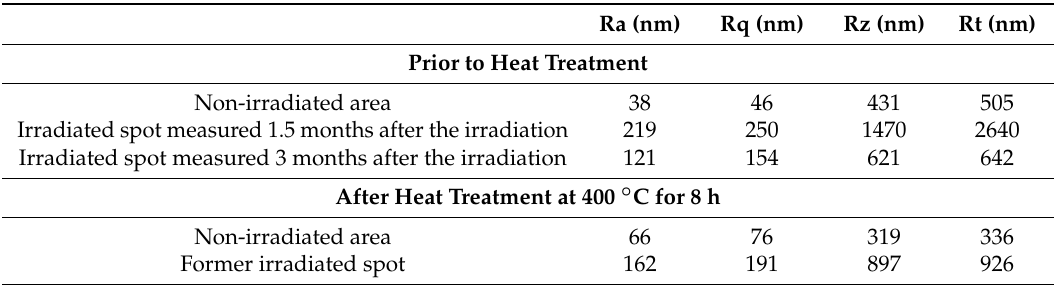
Table 3. Surface roughness parameters of the glass surface measured after (1.5 and 3 months) irradiation and after heat